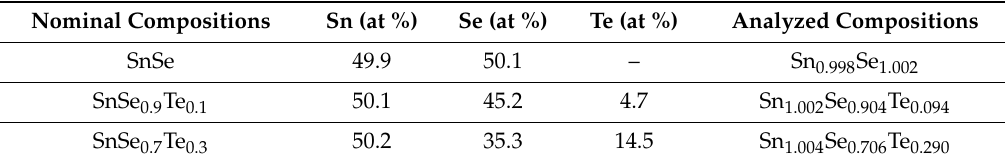
Figure 3. Electron probe microanalyzer (EPMA) images of ( a ) SnSe, ( b ) SnSe 0.9 Te 0.1 , and ( c ) SnSe 0.7 Te 0.3 . Images with (Sn), (Se), and (Te) show the distribution of the elements Sn, Se, and Te, respectively. Table 1. Tin (Sn), selenium (Se), and tellurium (Te) atomic ratios and chemical compositions of